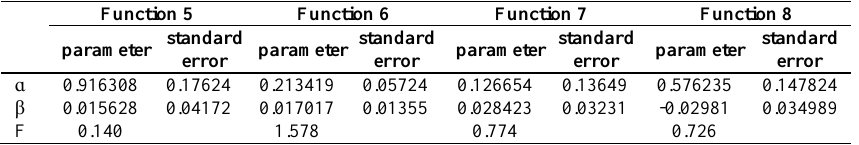
Table 4. Results of modeling for connection “size of spending – its entropy” for